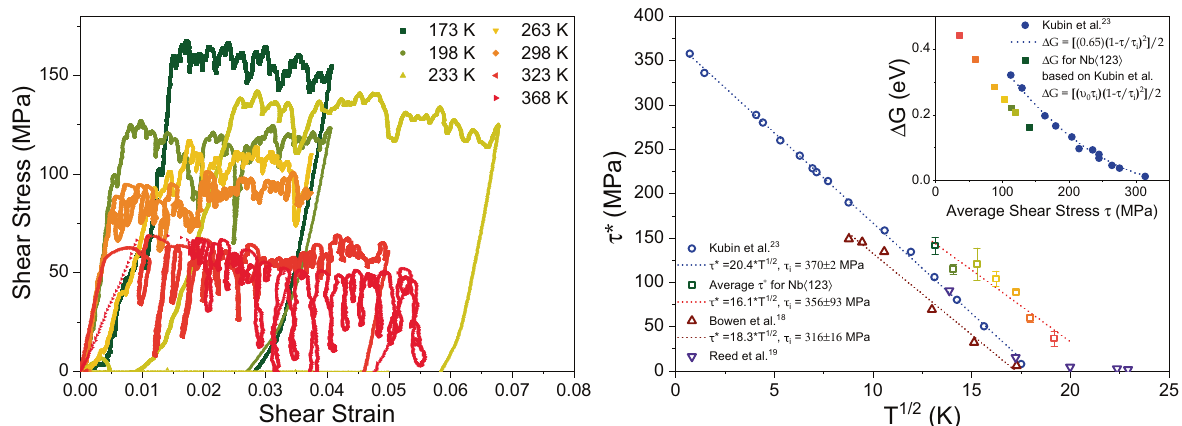
Fig. 1 Temperature-dependent microplastic fl ow of Nb. a Compressive shear-stress shear-strain curves obtained at a displacement rate of 0.6 nm s − 1 on Nb h 123 i -microcrystal at temperatures ranging between 173 and 368 K. b Shear stress at which events occur along the curves in a as a function of T 1 = 2 (represented by the squares). The error bars correspond to the standard deviation. Literature data from refs. 18,19,23 is also included for comparison, all of which follow the same trend based on the used model by Kubin et al. 23 . The Inset shows the calculated barrier energy based on the same